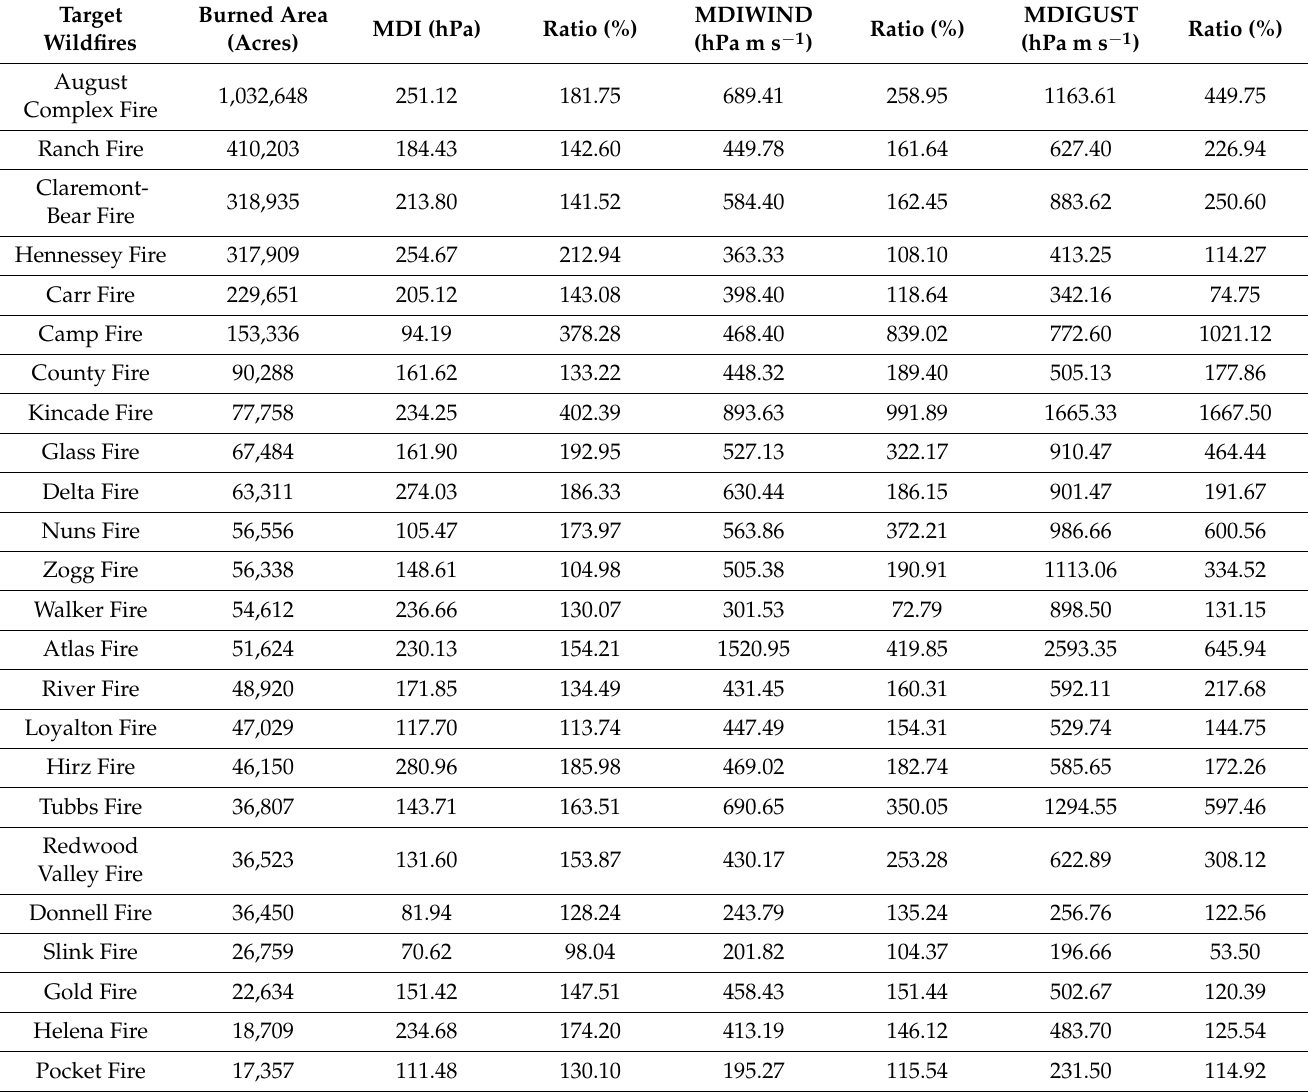
Table 3. Daily averaged hydrological/meteorological indices at the ignition location on the ignition date for each target wildfire. Each index’s ratio represents the ratio of the daily averaged ignition location index in the fire-year to the corresponding non-fire-year averaged